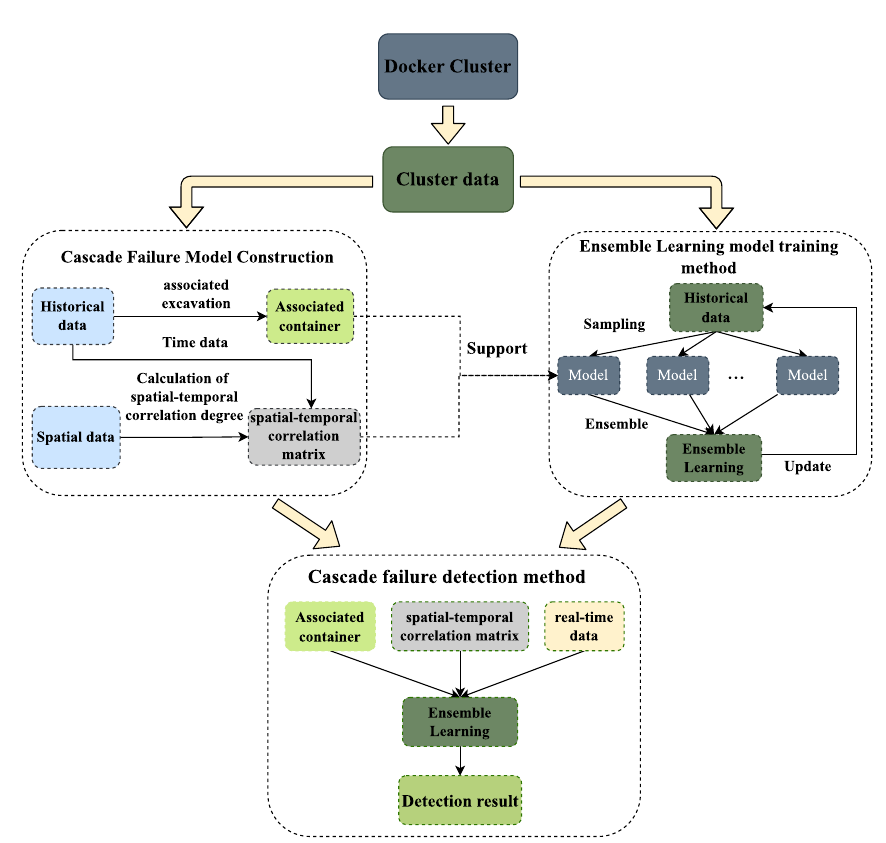
Fig. 1 The framework of cascade fault detection based on spatial–temporal